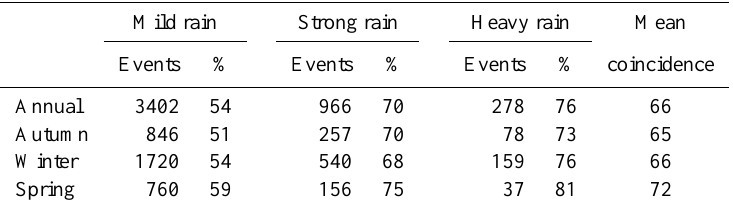
figure, white dashed circles correspond to the radius of the cyclone centers and red circle to the radius of the red cyclone center which is the cyclone evident on the METEOSAT im- age. MS scheme estimation of the cyclone is accurate, com- paring the cyclone location and its radius to the actual phe- nomenon recorded in the METEOSAT image. The cyclone track has an eastward direction, and at 00:00 UTC on 17 Oc- tober, centered at a southwest position in relation to Crete’s bounded area, it starts precipitating in agreement with Gril- lakis and Tsanis